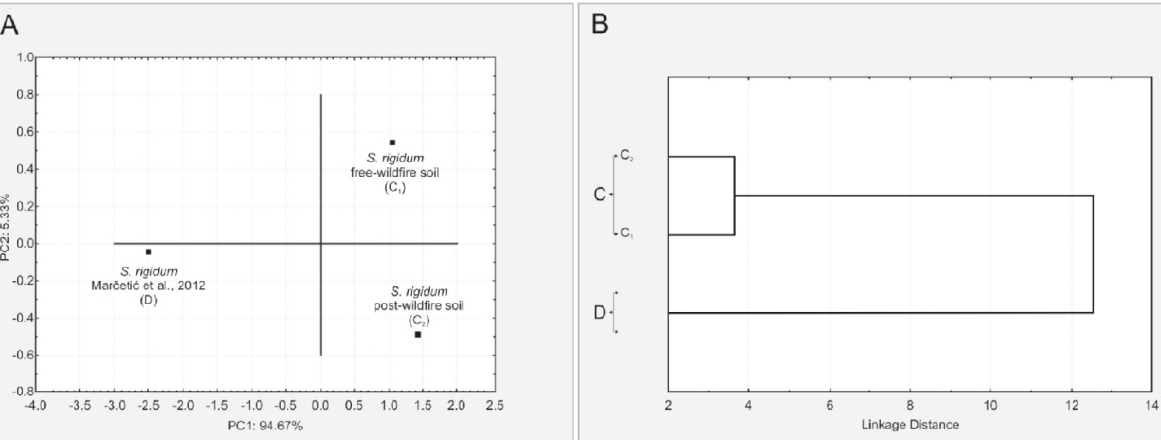
Figure 2: PCA and HCA of essential oils based on their chemical classes: (A) the score plot of tested essential oils; (B) the corresponding dendrogram. Examined compound groups are described by numbers (Table 1).